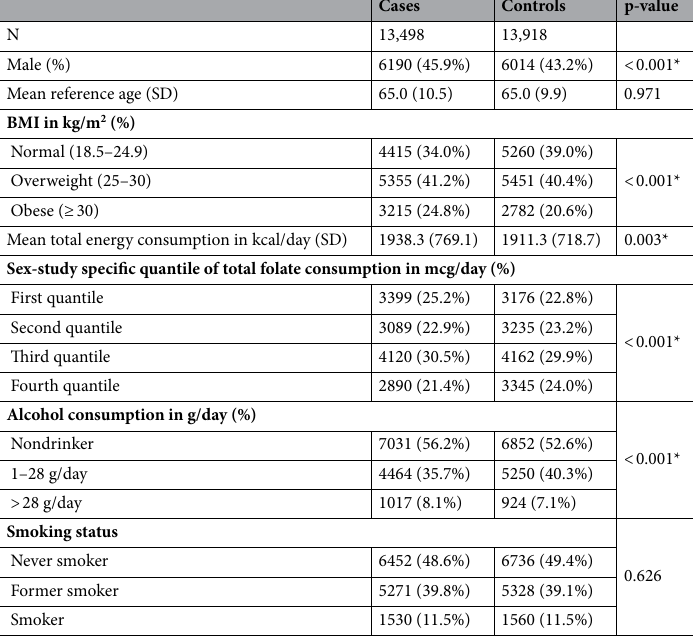
Table 1. Characteristics of participants from all studies by colorectal cancer case/control status and Chi- square p-values for statistical differences. Continuous variables were presented as mean and standard deviation (SD) and p-values were calculated using Student’s t test for difference in means; categorical variables were presented as n (%) and p-values were calculated using Pearson Chi-square test. *Statistically significant difference between cases and